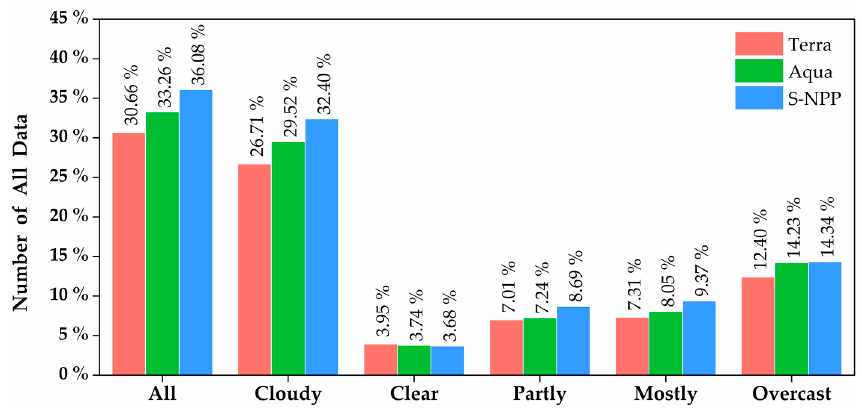
Figure 9. Number of Terra, Aqua and S-NPP data compared to all data according to the clear fraction. Clouds were subdivided according to clear fraction (all: 0–100%; cloudy: 0–95%; clear: ≥ 95%; partly cloudy: 50–95%; mostly cloudy: 5–50%; overcast: <